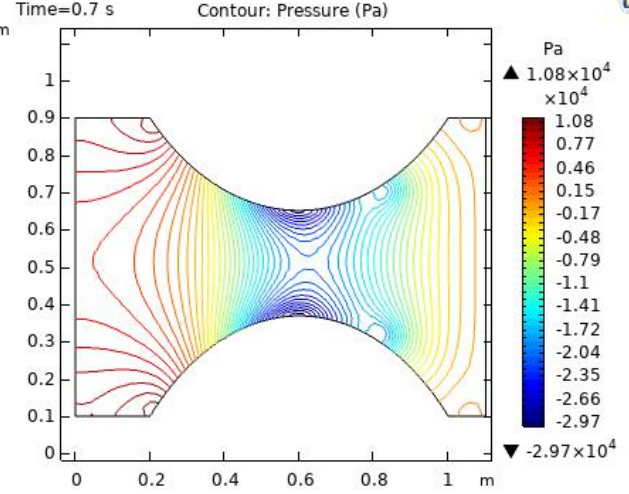
Figure 15. The pressure profile at t = 0.7 s.